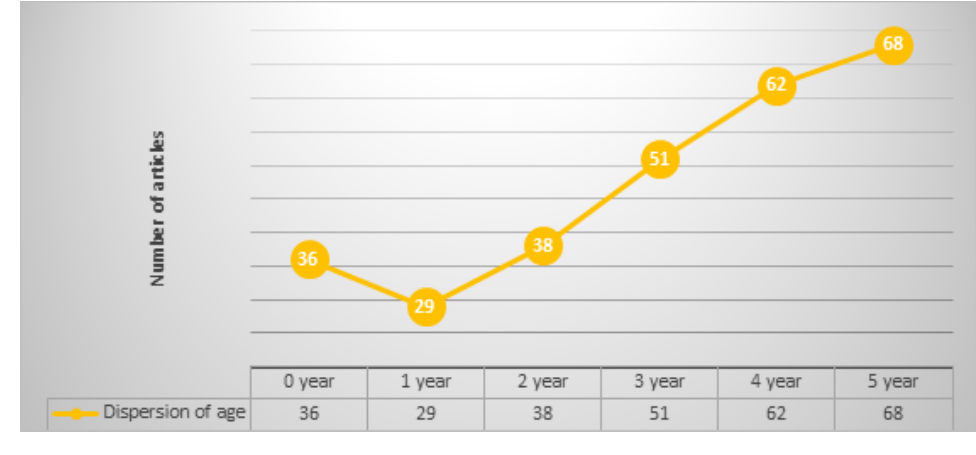
FFigigururee 1.1. DistributionDistribution ofof aaggee